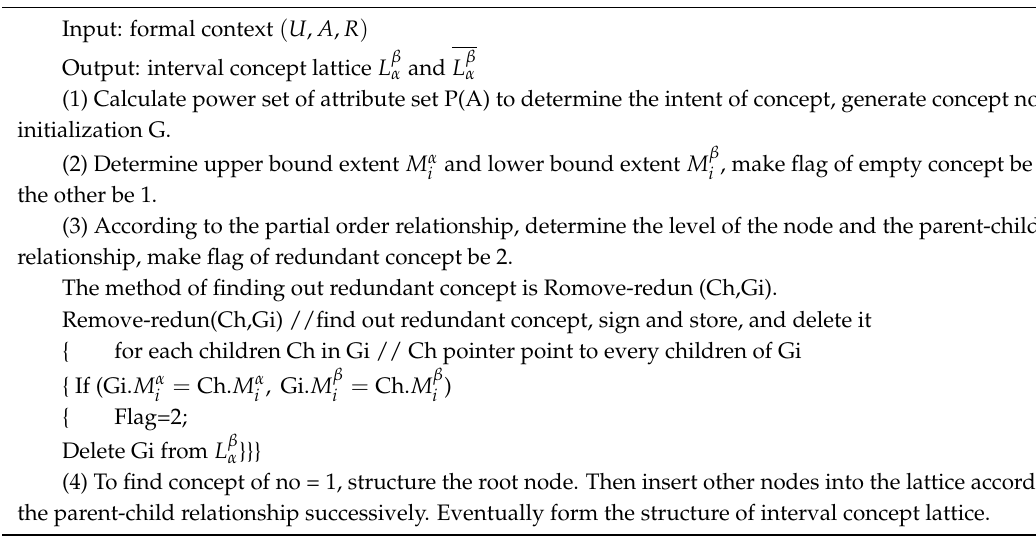
Algorithm 1. Improved ICAICL